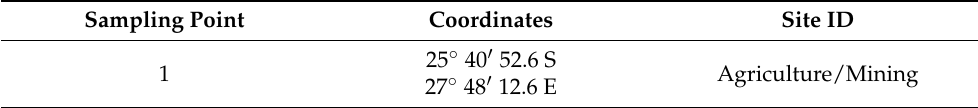
Table 6. The coordinates of the Crocodile River Water Sampling